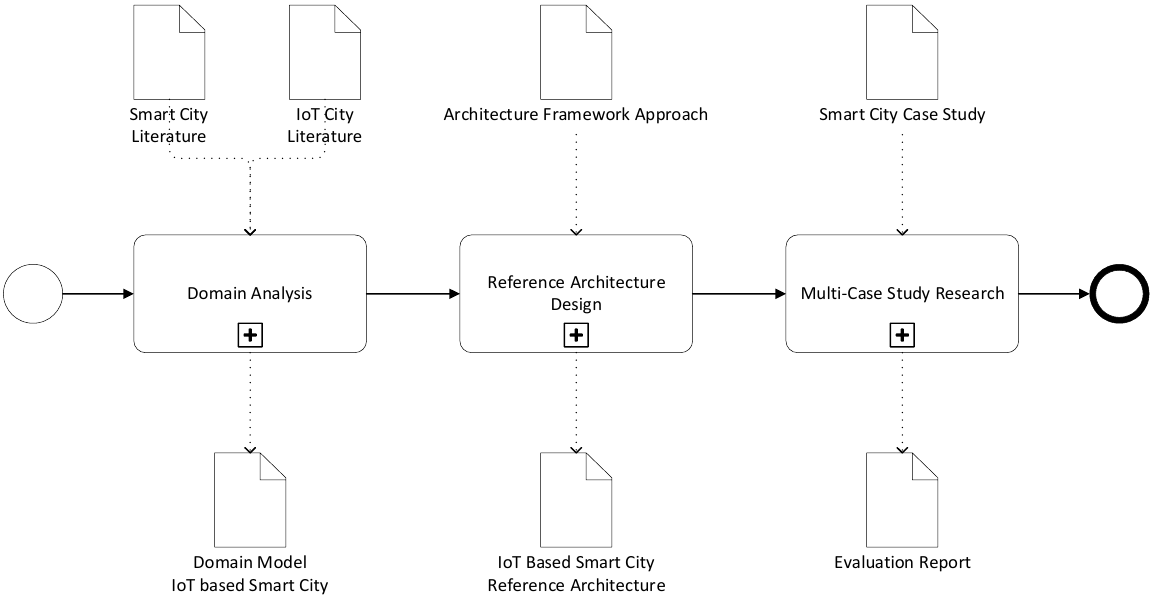
Figure 2. Adopted Research Methodology .